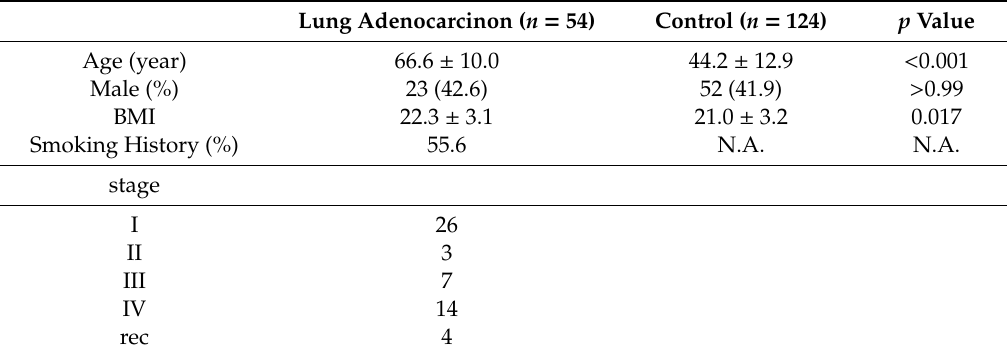
Table 1. Characteristics of lung adenocarcinoma patients and controls. 124 healthy volunteers and 54 patients with lung adenocarcinoma were enrolled. Age, sex (male %), BMI, and smoking history in each group are shown. Lung Adenocarcinon ( n = 54) Control ( n =